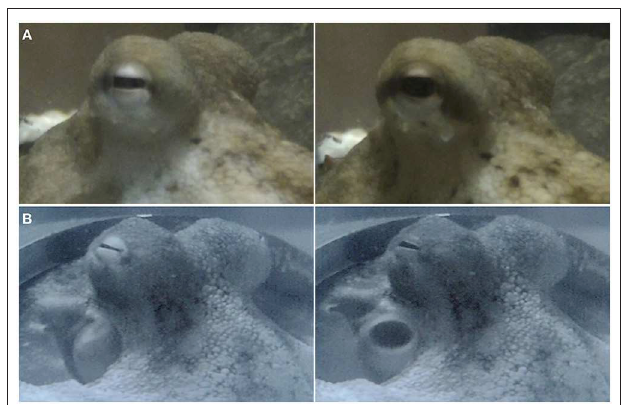
FIGURE 2 | Two examples of octopus fixation reflex. (Left) Stimulus not present. (Right) Pupil expands along with chromatophores around the eye as a response to the appearance of the sinusoidal grating. The different features of the fixation response can be expressed at various degrees of intensity: (A) shows a strong pupil expansion and expression of the “eye bar,” whereas (B) shows a good example of the “dark eye ring.” (B) Reprinted with permission from Nahmad-Rohen and Vorobyev